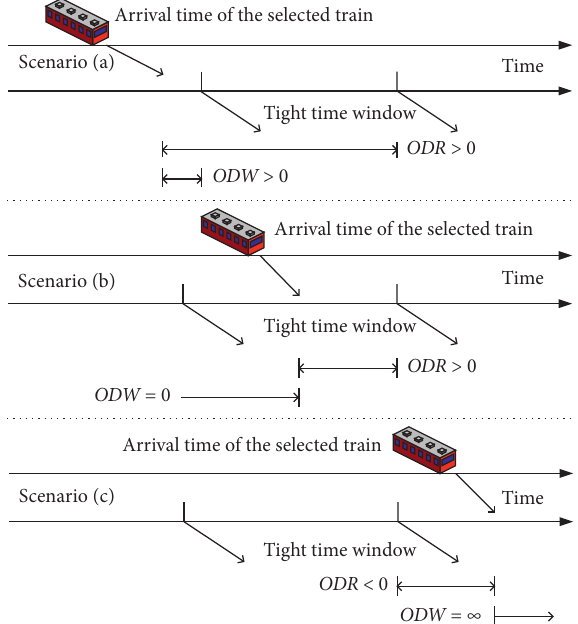
Figure 2: Three different relationships between the order arrival time and the tight time